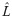
Trajectories of various rates of reproductive energy allocation and somatic growth.Variations in the rates of reproductive energy allocation (a and b) and somatic growth (c and d) with different values of q (a and c) and τ (b and d) using the present function (Eqs 13 and 14). Values of q and τ are shown in the graphs, while values for the other parameters are fixed as L^ = 200, r = 1, τ = 2, and t0 = 0 for (a) and (b); and L^ = 200, r = 1, q = 0.4, and t0 = 0 for (c) and (d).